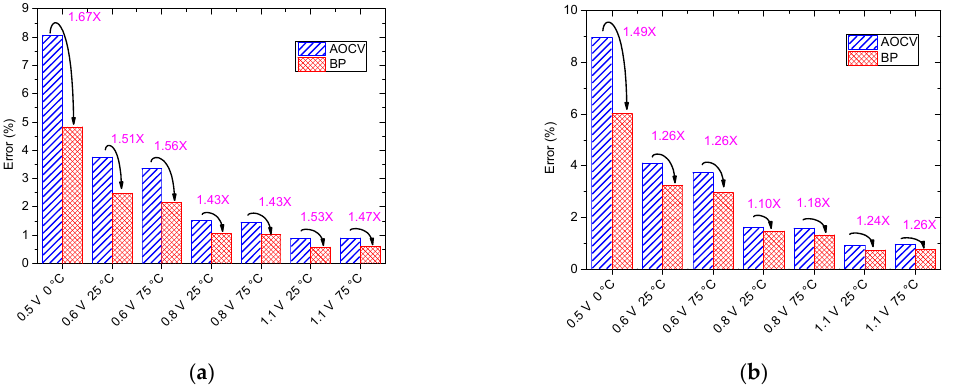
Figure 5. Path variation delay predicted error at td +x σ at a single corner. ( a ) train error; ( b )test error.